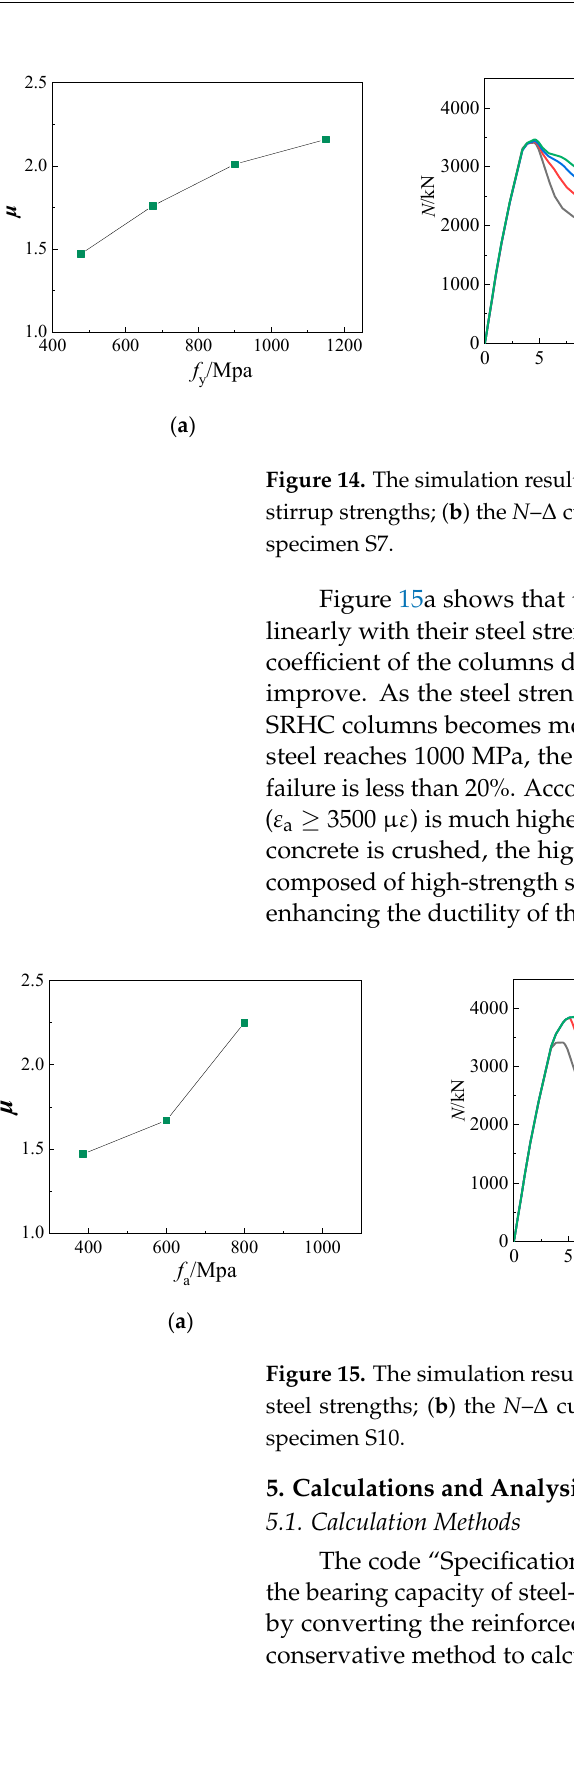
© Figure 13. The simulation results at different stirrup spacings: ( a ) the ductility coefficient at different stirrup spacings; ( b ) the N – Δ curves at various stirrup spacings; ( c ) the rebar stress nephogram of specimen S3. Table 7 and Figure 14a demonstrate that increasing the strength of the stirrups can enhance the ductility coefficient of the SRHC columns, albeit limitedly. Moreover, with an increase in the stirrup strength, the increase in the ductility coefficient of the SRHC columns shows a decreasing trend. Raising the stirrup strength from 477 MPa to 675, 900,